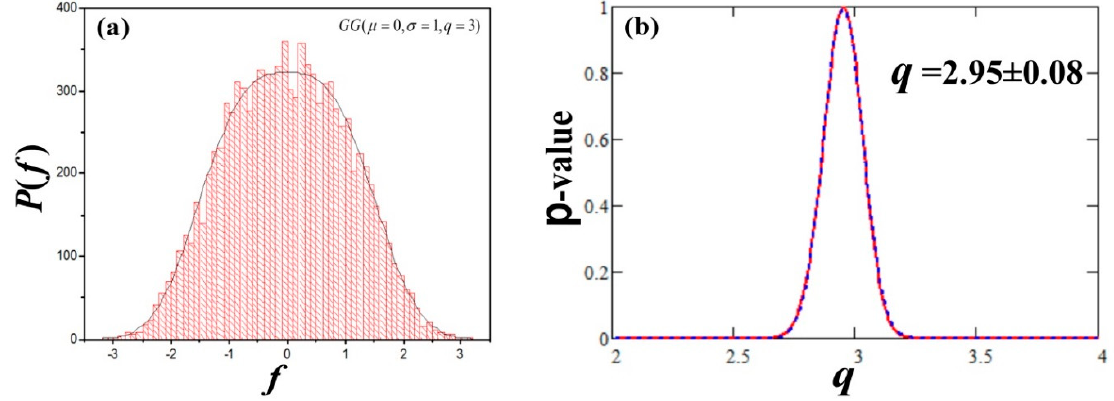
Figure 7. ( a ) The N = 10 4 data points of the examined time series are distributed with f i ∼ GG . ( b ) The derived p -value is plotted as a function of the q-norm, where it ( µ = 0, σ = 1, q = 3 ) . ( b ) The derived p -value is plotted as a function of the q-norm, where it is maximized for q ≈ 3. (Modified from [12]). is maximized for q ≈ 3. (Modified from [12]).